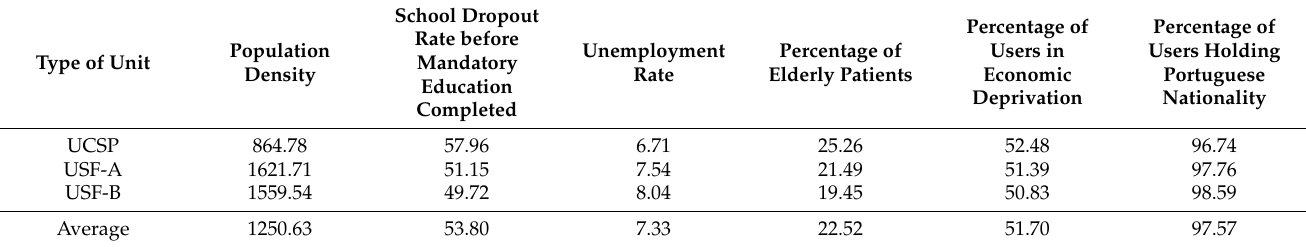
Table 3. Results of context factors by PHC unit type